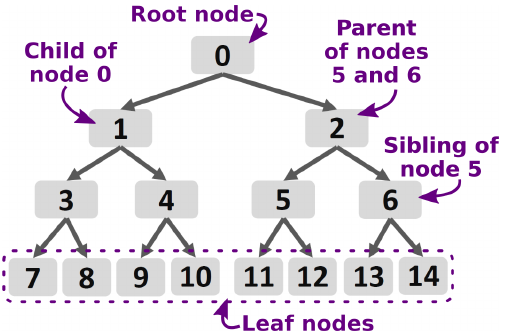
Figure 1. Binary tree containing 15 nodes with possible indices ac- cording to level-order tree